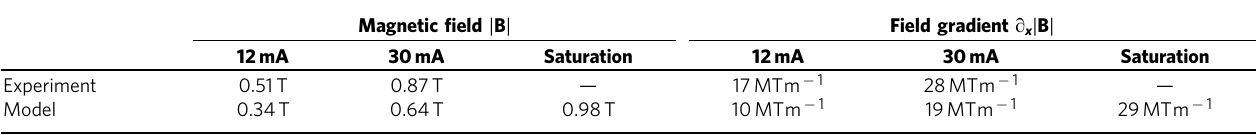
Valuesweremeasuredat z ¼ 5nmandarereportedfordrivecurrentsof12mA(polemagnetization0.83 ± 0.07T),30mA(1.57 ± 0.08T)andformagneticsaturation(2.4T),respectively.Theestimated errorfortheexperimentalvalues is þ 28%/ (cid:2) 11%duetotheuncertaintyinthetipvolume.Themodelvaluesareprobablyslightlyoverestimatedduetothefew-nmthickprotectivelayerof diamond-like carbon and Pt on top of the write pole. See Supplementary Material for